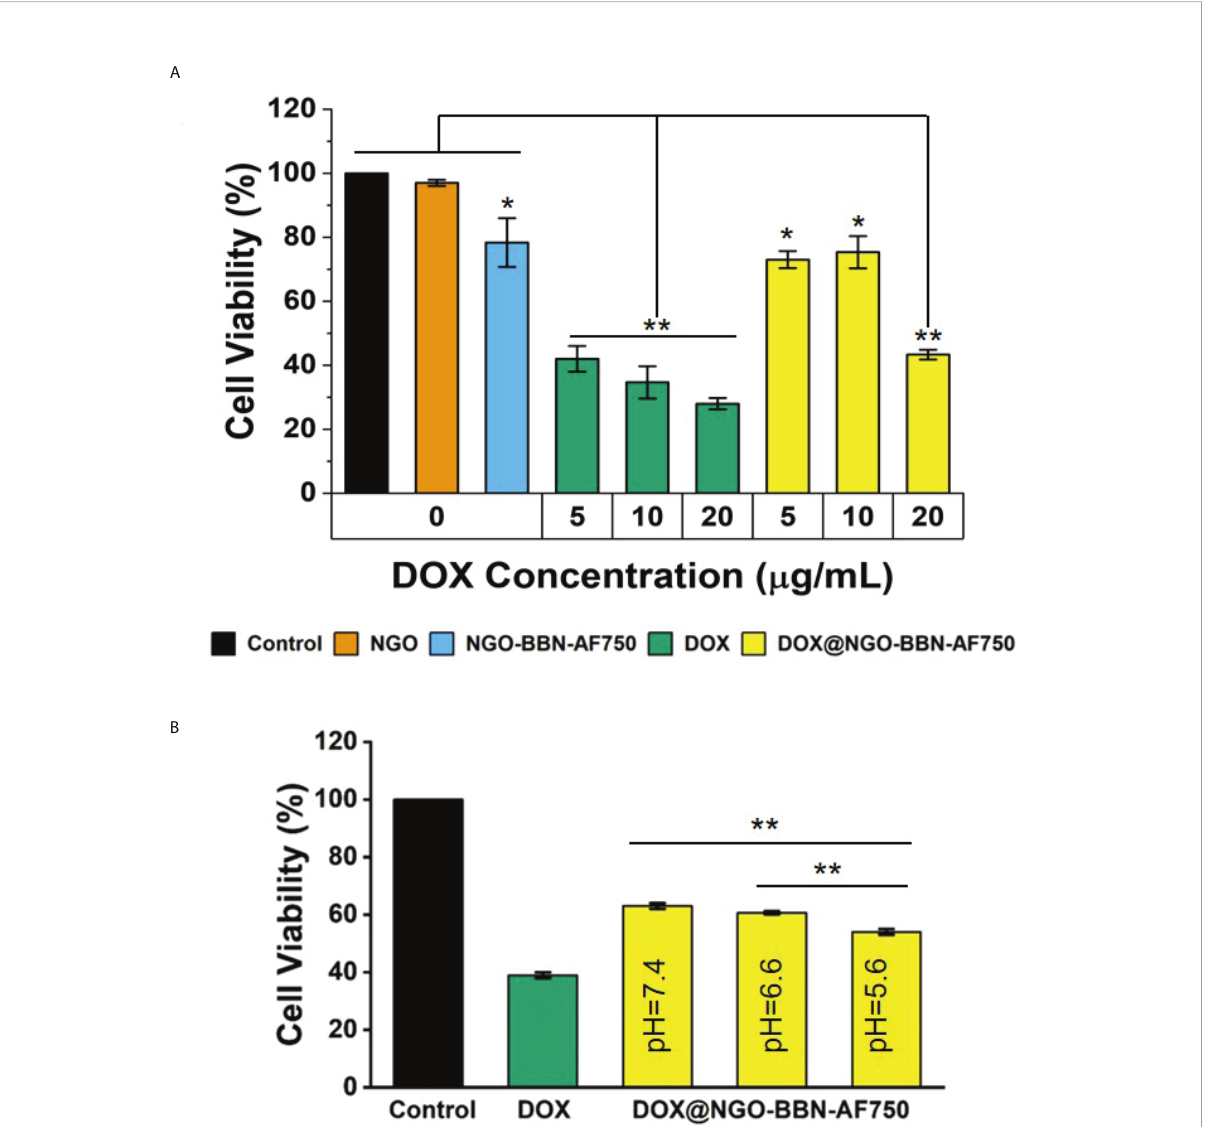
FIGURE 6 In vitro cytotoxicity of DOX and DOX@NGO-BBN-AF750 nanoprobes on HSC-3 cells. (A) Cell viability after treatment with NGO and NGO-BBN- AF750 or DOX and DOX@NGO-BBN-AF750 at different DOX concentrations (pH = 7.4). ** P < 0.01 compared with control, NGO, and NGO- BBN-AAF750 groups. * P < 0.05 compared with the control group. (B) Cell viability after treatment with DOX@NGO-BBN-AF750 at different pH environments (DOX = 5 µg/ml). Data were obtained from n = 5 measurements and are presented as mean ± SD. ** P <